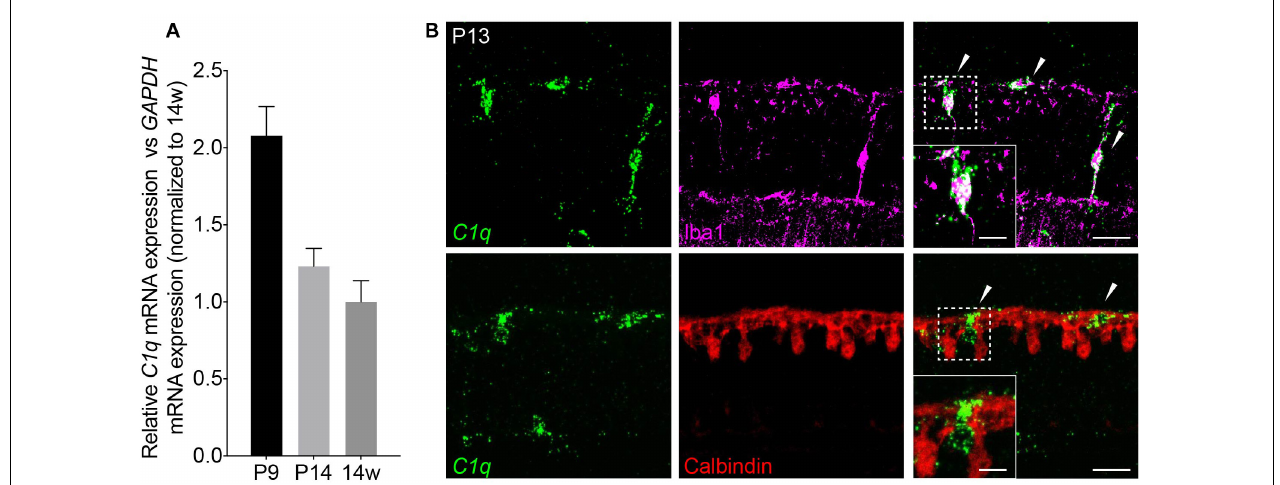
FIGURE 3 | C1q is expressed in retina microglia during development. (A) qRT-PCR for C1q at P9, P14, and 14 weeks. Values represent the fold mRNA expression level relative to the levels detected in adult animals following normalization to GAPDH . (B) Representative fluorescent in situ hybridization images at P13 of C1q (green) co-stained with either Iba1 (magenta) or calbindin (red) to label microglia and horizontal cells, respectively. C1q colocalizes with microglia but not with horizontal cells in the outer retina at this time (arrowheads). Inset shows C1q expression in Iba1-positive microglia that is absent in calbindin-positive horizontal cells. Scale bars = 25 and 10 µ m